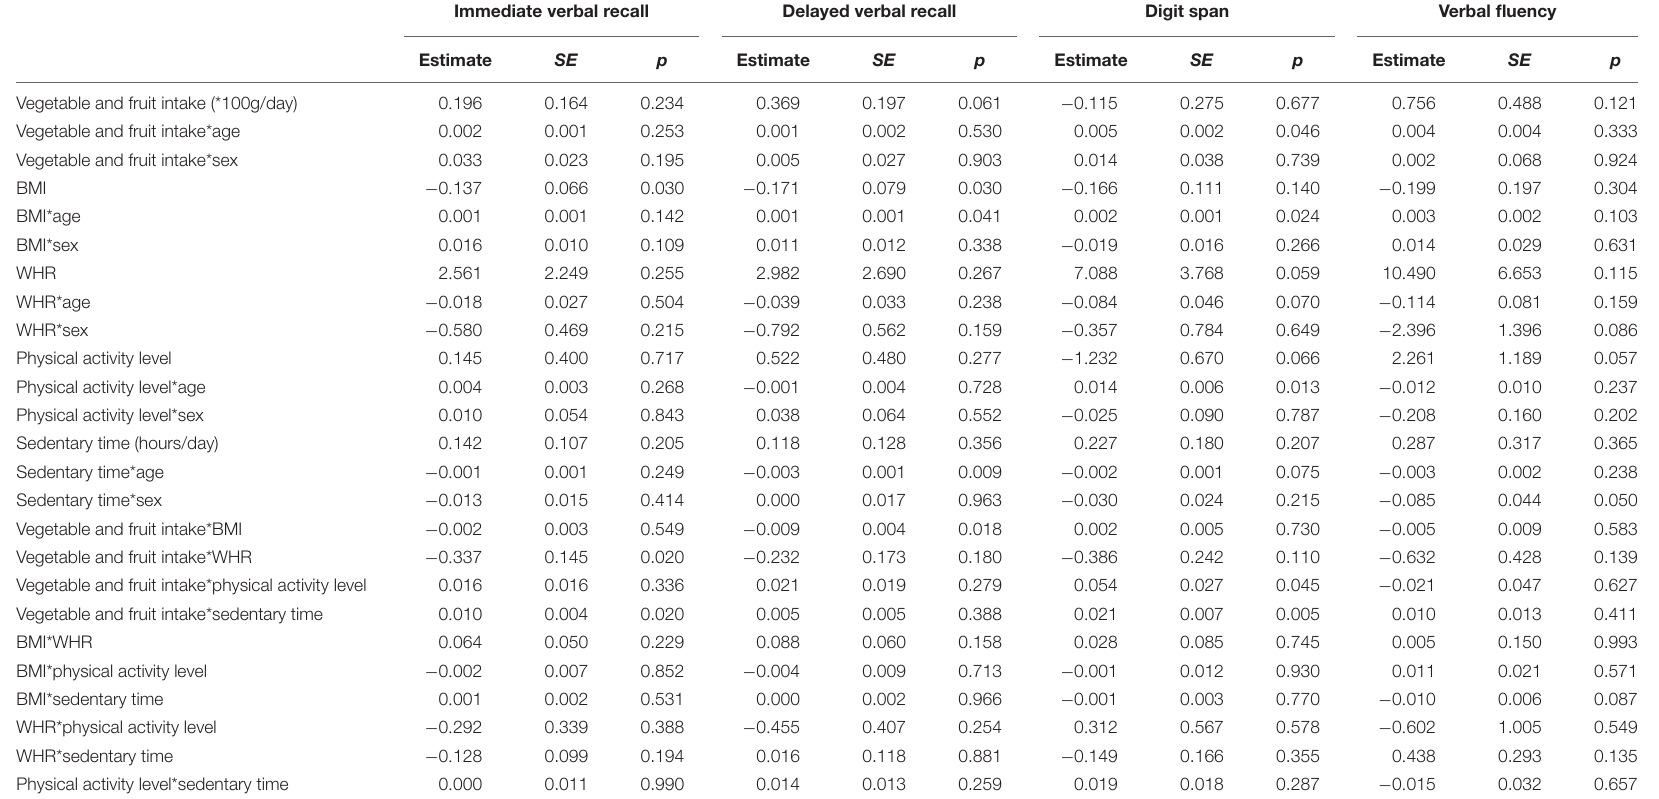
TABLE 4 | Contemporaneous associations between lifestyle factors and cognitive scores including